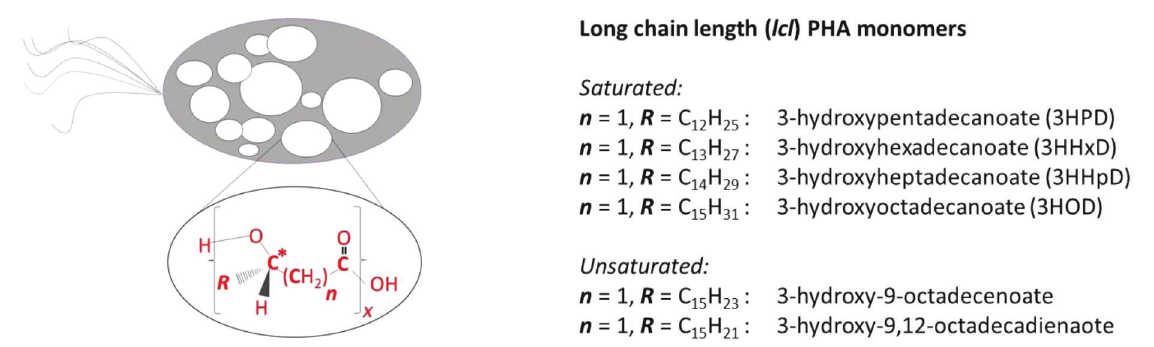
Fig. 4 – Monomers of mcl-PHA in PHA polyesters discussed in the present